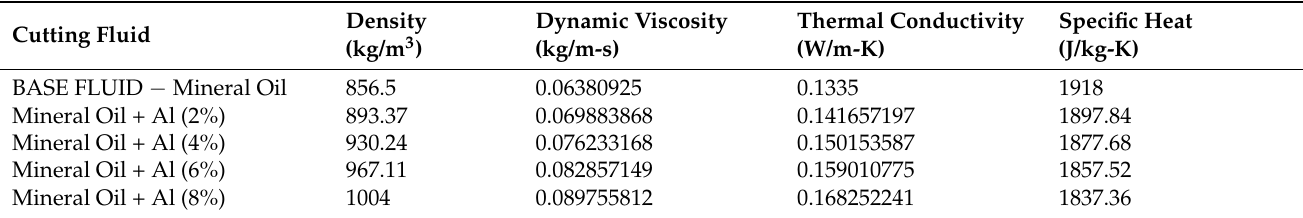
Table 4. Thermophysical and mechanical properties of mineral oil dispersed with